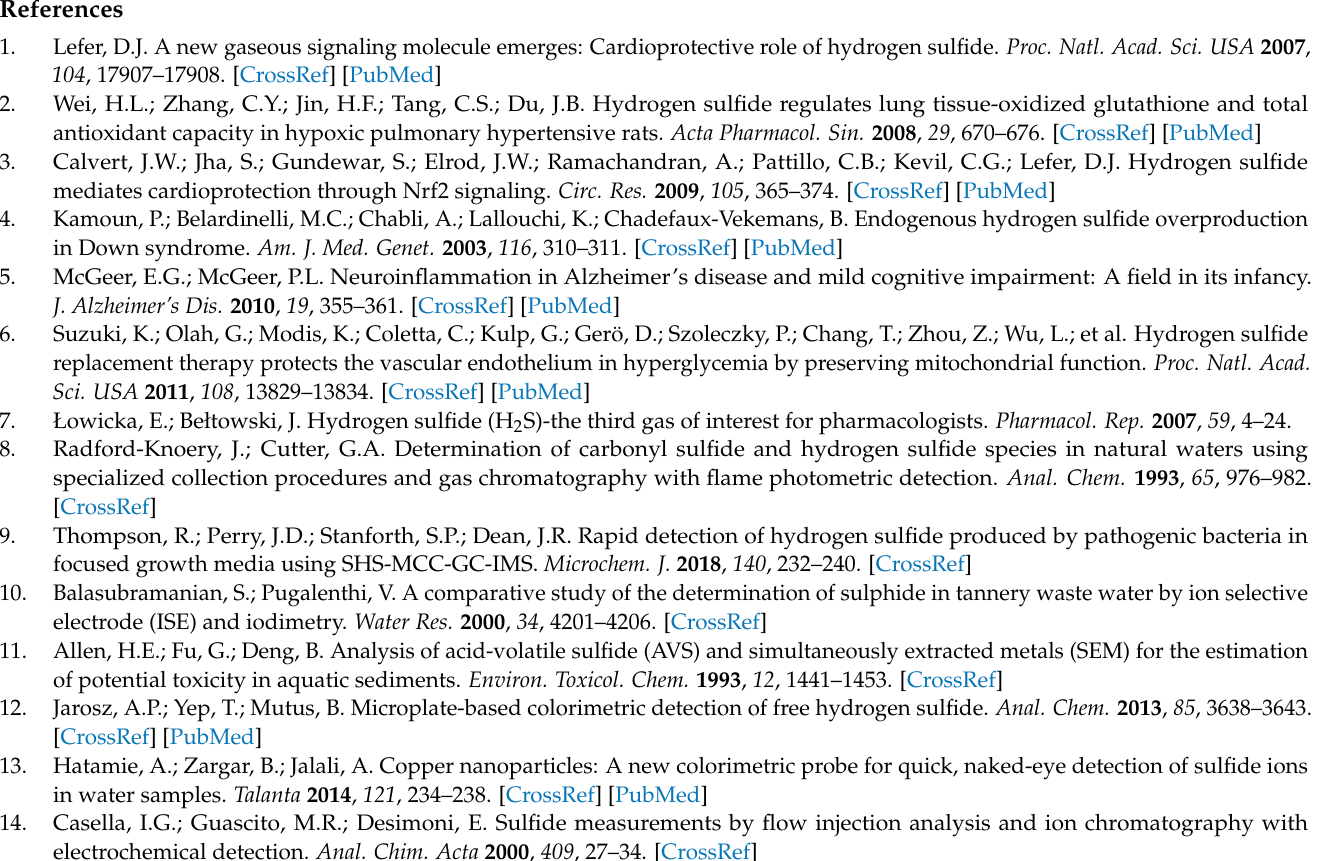
( c ) 2-PDA@Co3O4 NPs. Scale bar: 50 nm; Figure S3: XPS spectra of PDA@Co3O4 NPs; Figure S4: Evaluations for the other oxidoreductase-like activities of PDA@Co3O4 NPs and bare Co3O4 NPs. ( a ) POD-, ( b ) OXD- and ( c ) SOD-like activities; Figure S5: Effects of ( a ) concentrations of PDA@Co3O4 NPs, ( b ) pH, and ( c ) temperature on the catalase-like activity of PDA@Co3O4 NPs. Effects of pH and temperature on the activity of natural catalase were compared; Figure S6: ( a ) Michaelis– Menten curve for the catalase-like activity of PDA@Co3O4 NPs at diverse concentrations of H2O2 and ( b ) their corresponding Lineweaver–Burk plots (n = 3); Figure S7: Fluorescence spectra of PDA@Co3O4 NPs-based biosensor toward diverse concentrations of S2 − ; Figure S8: Particle size distributions of PDA@Co3O4 NPs in the absence and presence of S2 − (1 mM); Table S1: Elemental composition ratio of PDA@Co3O4 NPs; Table S2: Comparison of the kinetic parameters of catalase-like PDA@Co3O4 NPs with those of natural catalase and previously reported Co3O4-based